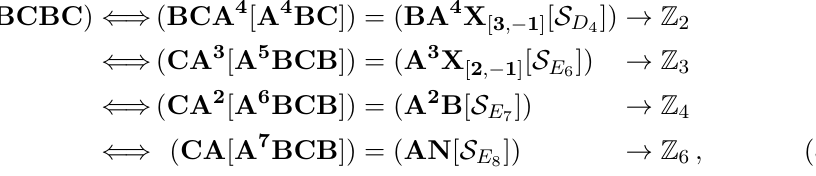
figure 26. The flavor symmetry of the Z be seen from rearrangements of 7-brane configurations for SU(2) + 8 F